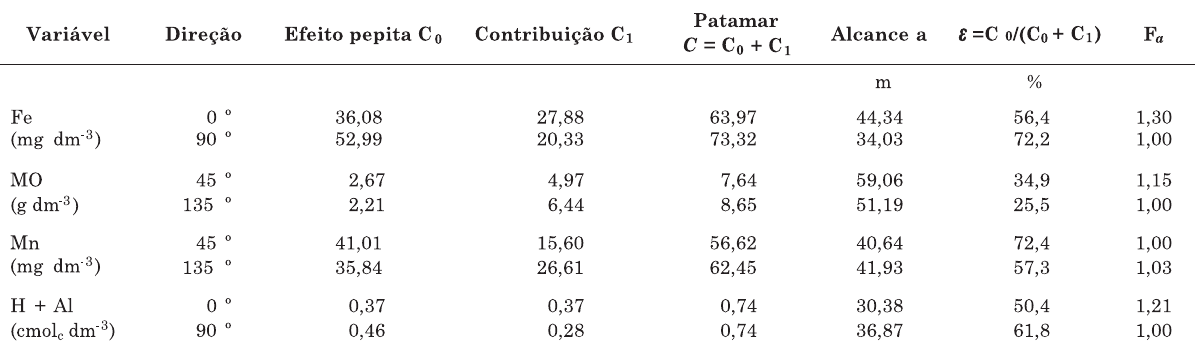
F : fator de anisotropia; α : ângulo de maior continuidade espacial; ε : efeito pepita a